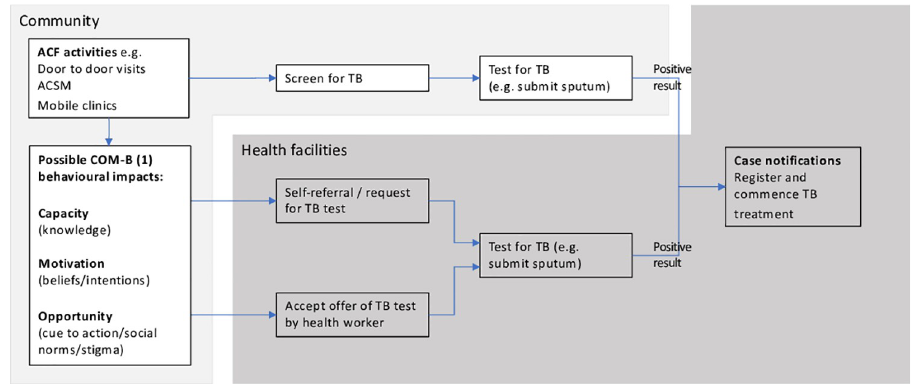
Fig 1. Conceptual framework for how tuberculosis active case finding may affect subsequent healthcare-seeking behaviour. Footnote: (1) Capacity, Opportunity and Motivation are the three domains of the COM-B behavioural theory